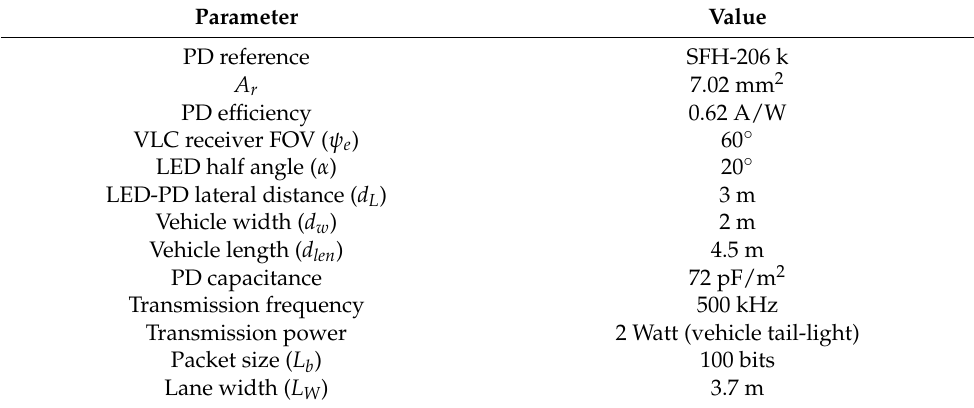
Figure 3. Illustration of the multi-user interference area for a given pair of V2V VLC transmitters (Tx) − receiver (Rx). Table 1. MATLAB simulation